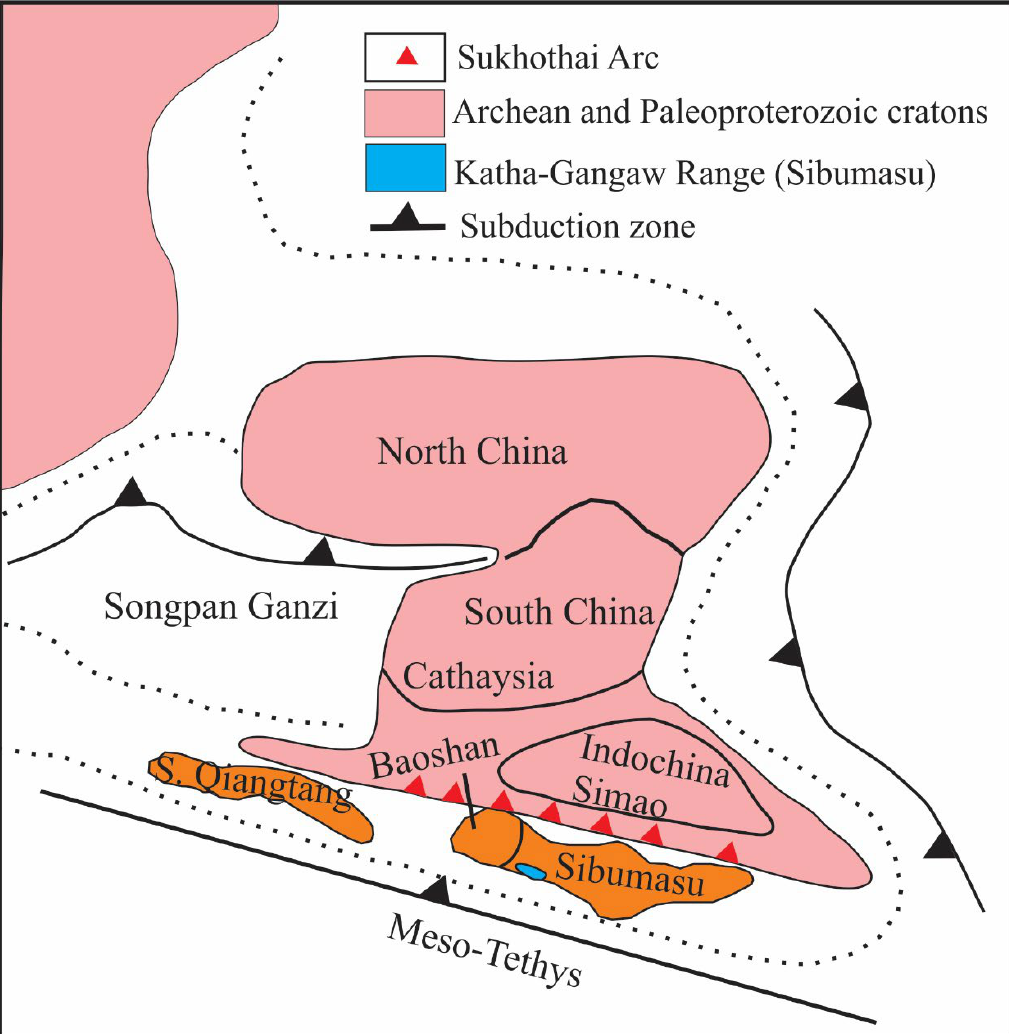
Figure 9. Simplified Late Triassic paleogeographic reconstruction (not to scale) including North China, South China, Indochina, South Qiangtang, and Sibumasu block containing rocks of the Katha-Gangaw Range: modified from [1,23].